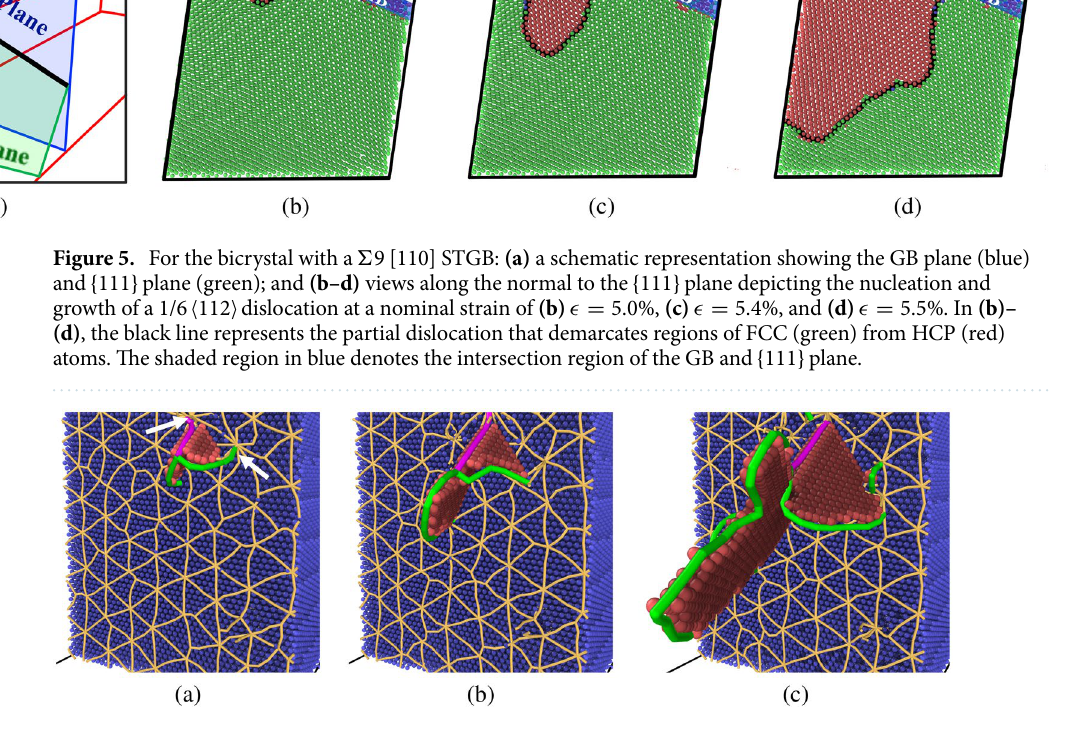
6.3% (Fig. 6c) are shown, where the grid of GB dislocations is colored in orange, atoms in one crystal are colored in blue, and ones in the second crystal are removed for a better visualization of the defect structures. The nucle- ated dislocation line is colored in green and atoms with HCP structures are in red. Supplementary Video 1 also shows an animation of this bicrystal system during the tensile deformation. At a tensile strain of ǫ = 6.1%, a 1/6 (cid:31) 112 (cid:30) partial dislocation line nucleated from the GB and grew by bowing out into the bulk crystal leaving behind a stacking fault. It is observed that the dislocation line has its ends pinned at two nodes of the GB dislocation network (see arrows in Fig. 6a). Again, the stress drop observed in the stress-strain curve for this bicrystal system (refer to Fig. 4d) corresponded to the nucleation of this partial dislocation from the GB. As shown in Supple- mentary Figs. S2 and S3 online, all bicrystal systems examined in this work exhibited similar trends to the ones depicted in Figs. 5 and 6. Such results suggest that GBs serve as heterogeneous nucleation sites for dislocations in the Cantor alloy, and upon further straining these line defects grow into the bulk crystals leaving behind faulted regions. In all bicrystal systems explored in this work, no trailing partials were observed to nucleate from the GBs. This effect was also observed in atomistic simulations of dislocation nucleation from GBs in pure metals 78,79 . Derlet and Van Swygenhoven 80 found that the emission of first partials was enough to relieve local stresses at GBs and that the emission of trailing partials was not necessary to accommodate the applied loading. Deformation mechanisms. The mechanical behavior of the bicrystal systems is explored at late stages of deformation. Figure 7a–c shows respectively snapshots of the bicrystals with (cid:31) 3 , (cid:31) 9 , and (cid:31) 19 [110] STGBs at a nominal tensile strain of ǫ = 6.3% . In these figures, GB and HCP atoms were labeled in blue and red, respec- tively, where HCP ordering is indicative of stacking faults. Atoms with FCC structures were removed to provide a better visualization of the defect structures. As can be seen from Fig. 7, the density of the nucleated partial dislocations and the resultant stacking faults at a given strain are dependent on the GBs present in these systems. For example, the bicrystal with a (cid:31) 9 [110] STGB shown in Fig. 7b exhibits higher density of faulted regions compared to the one with a (cid:31) 19 [110] STGB depicted in Fig. 7c. A close examination of the stress-strain curves for these bicrystals (refer to Fig. 4b) shows that the stress required to nucleate these partial dislocations was higher for the system with a (cid:31) 19 [110] STGB than ones with (cid:31) 9 and (cid:31) 3 [110] GBs. At a tensile strain ǫ = 15% , Fig. 7d–f shows respectively close-up views of the atomic structures (atoms colored in green and red denote FCC and HCP structures) for the bicrystals with a (cid:31) 3, (cid:31) 9 and (cid:31) 19 [110] STGBs, where planes of faulted atoms can be